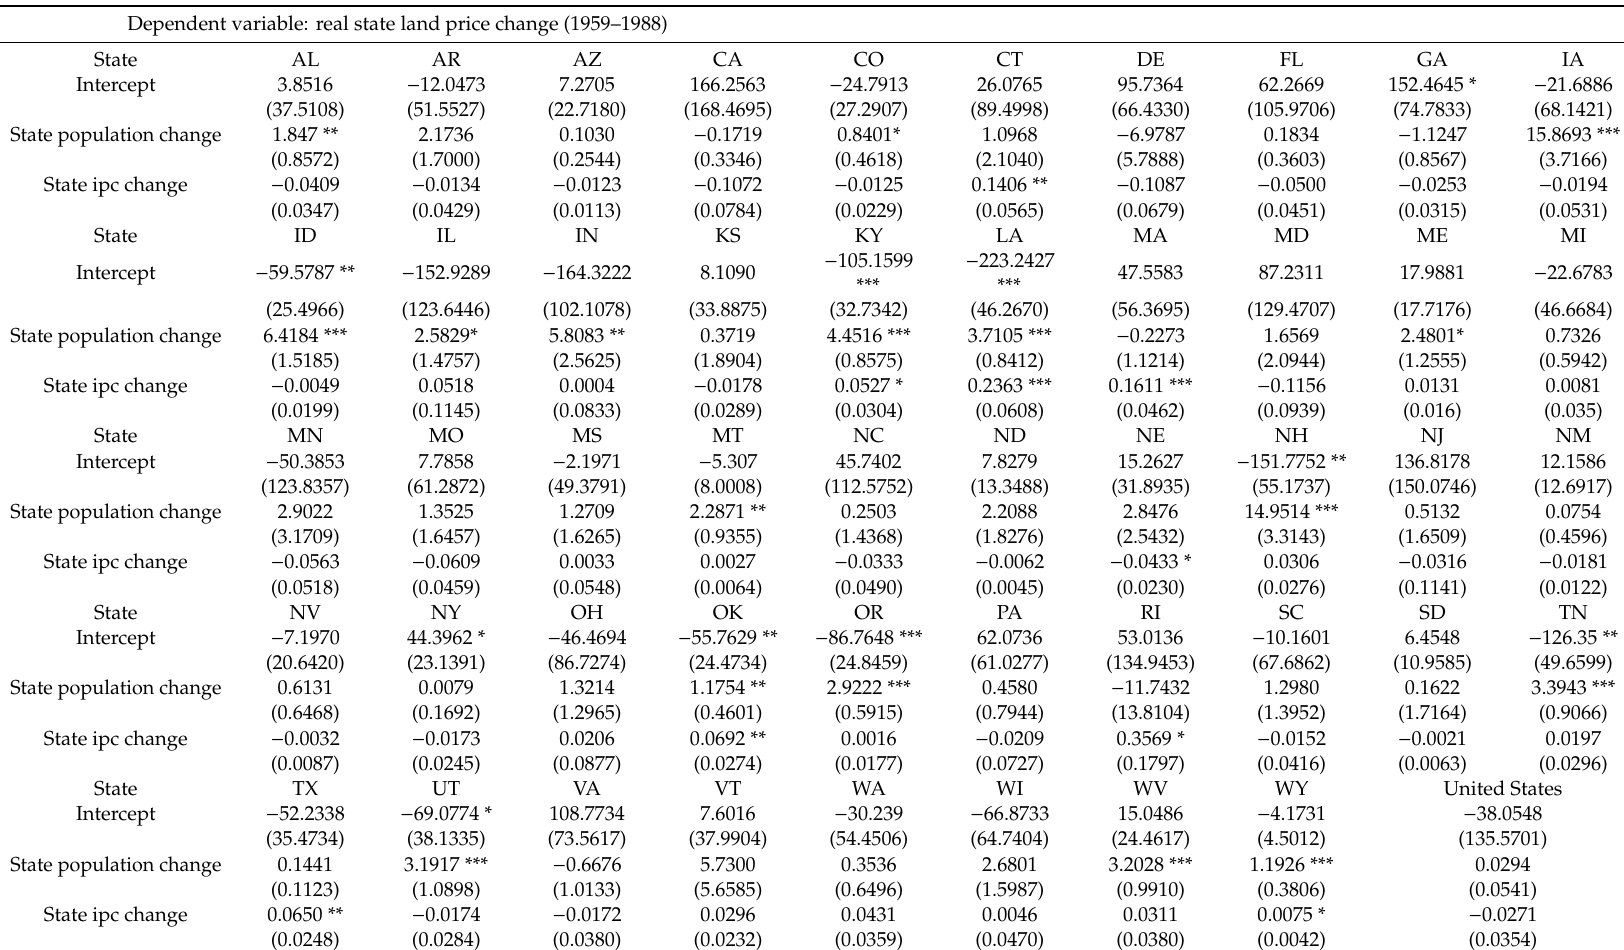
Table 5. The impact of state level population growth and income per capita growth on agriculture land price growth (1959–1988), real